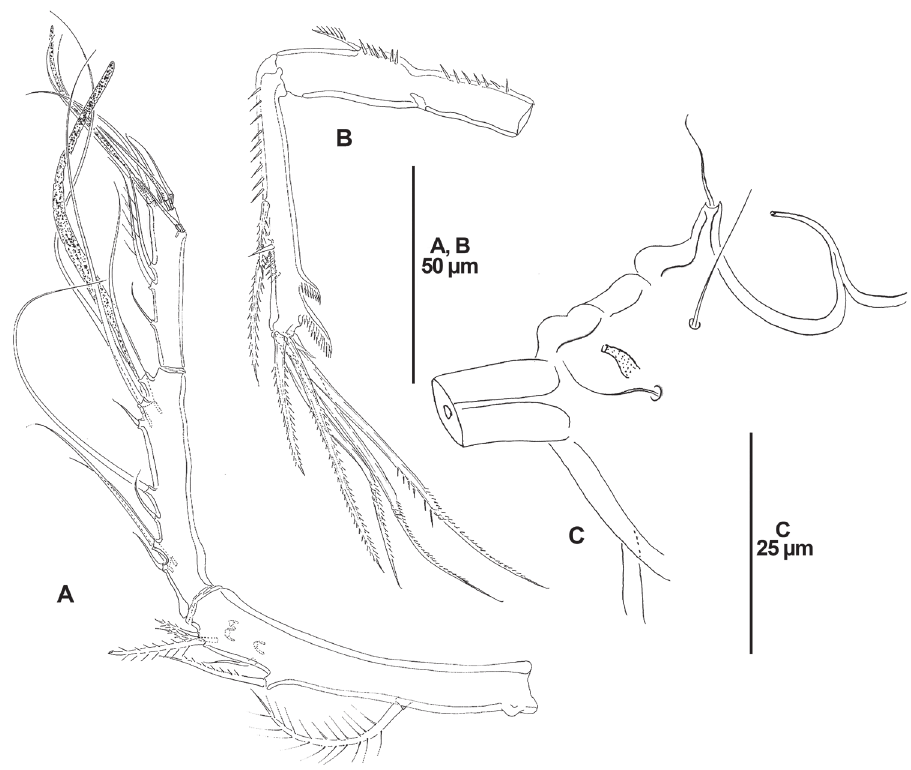
Figure 8. Dendropsyllus californiensis sp. n., female holotype. A antennule B antenna C distal outer corner of